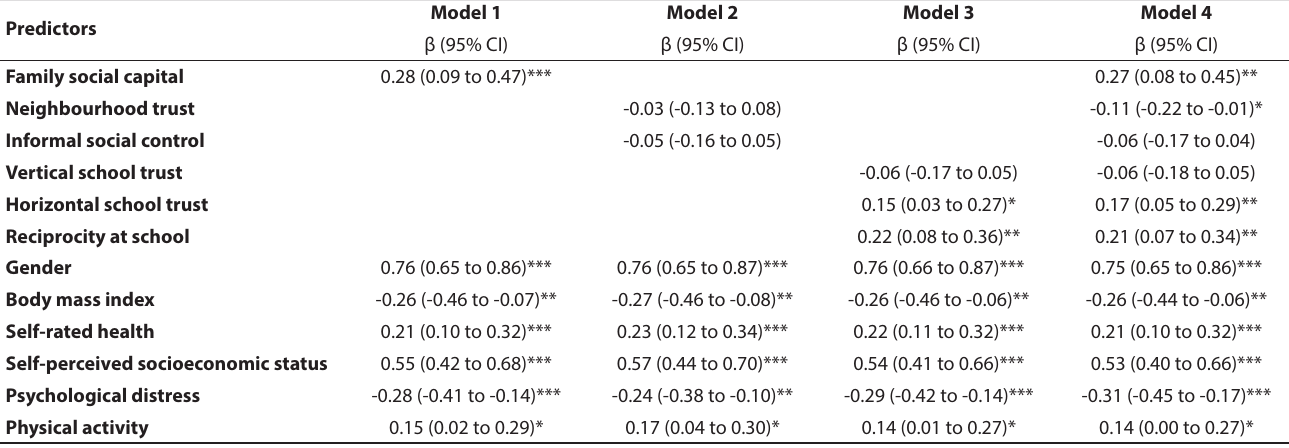
TABLE 3 Associations between Predictors with Individual High-school Academic Achievement